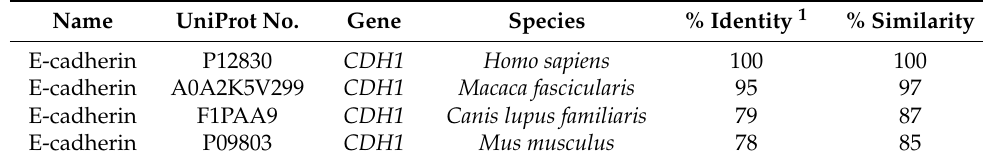
Table 2. Comparison of the extracellular domain of Cdh1 orthologues.